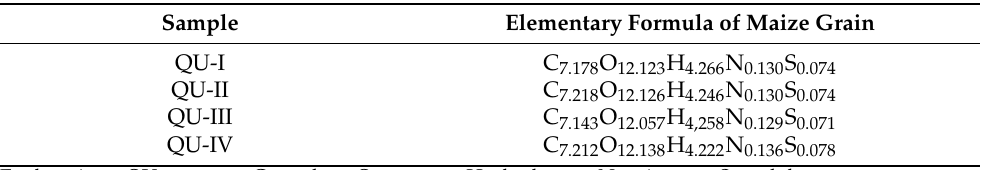
Table 2. Molar mass of individual elements and of starch, glucose, maltose, and maize grain sampled in each quarter.